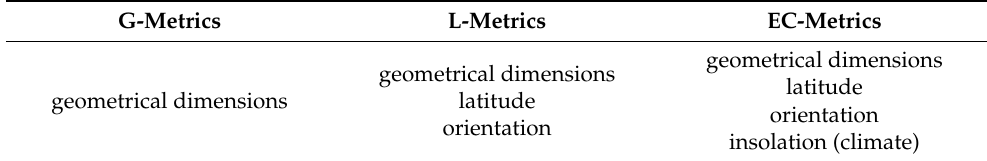
Table 3. The main influencing factors of each solar metric